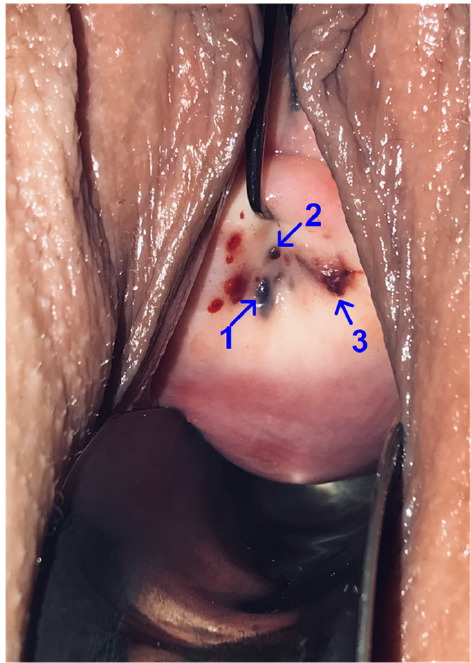
Figure 1. Localization of endometriotic lesions on the cervix during speculum exam. Foci of ectopic endometrium, up to 2 mm in size: 1—at 7 o’clock of the conditional dial, 2—in the area of the external os of the cervix, 3—the formation of a purple color at 5 o’clock of the conditional dial. The patient gave informed consent to the photographic recording and publication of the photograph.